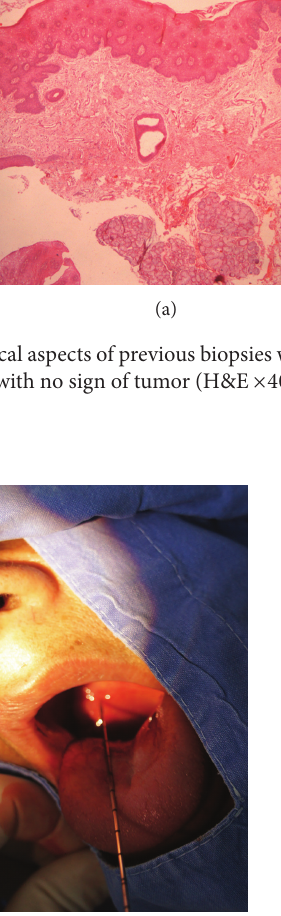
Figure 3: CNB procedure under local